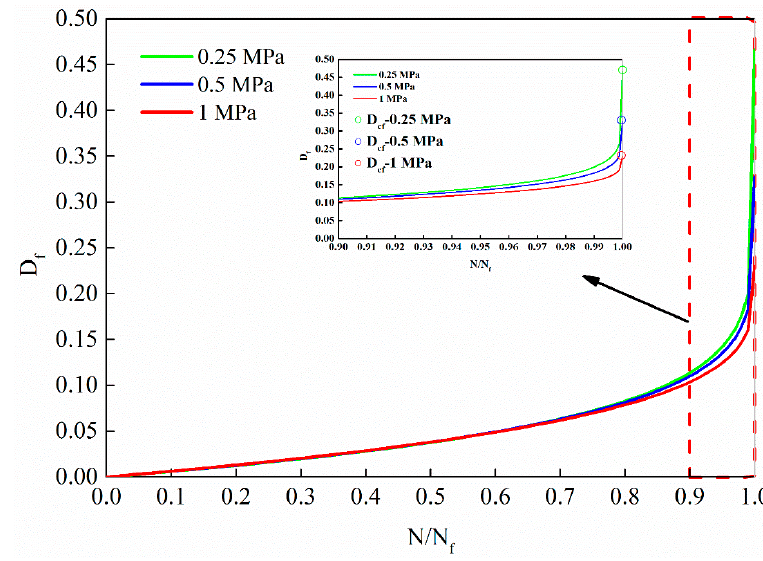
Figure 17. The damage evolution law based on dynamic modulus decay under different stress levels.